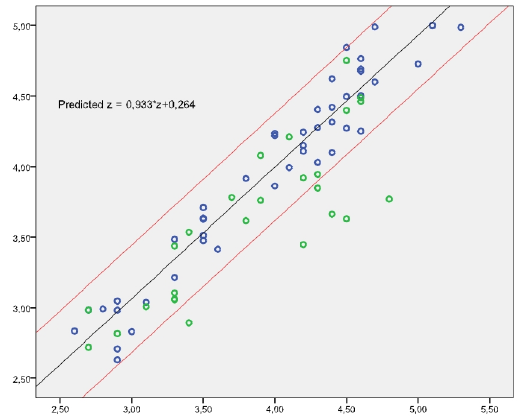
Figure 4. The graphic expression of confidence zone in area B. The symbolisms are given in figure